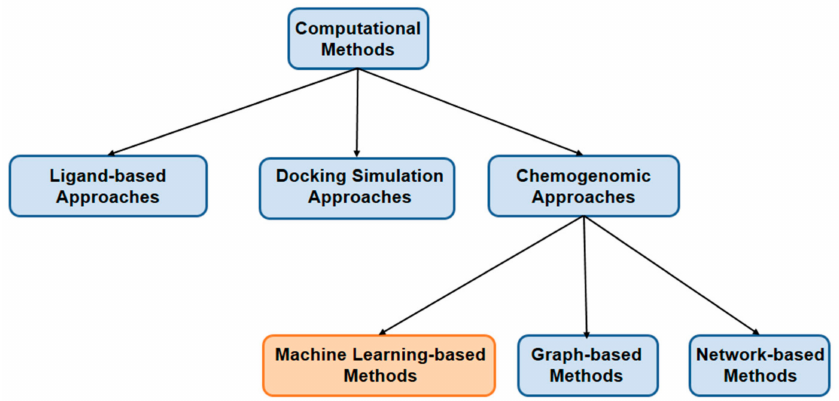
Figure 1. Branch diagram of recent computational methods for DTI